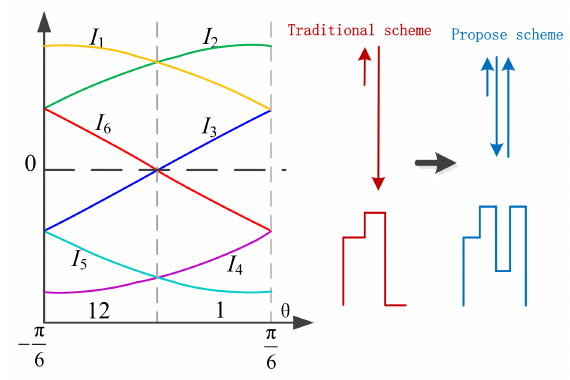
Figure 8. Relationship of variables in sector 12 and sector 1.